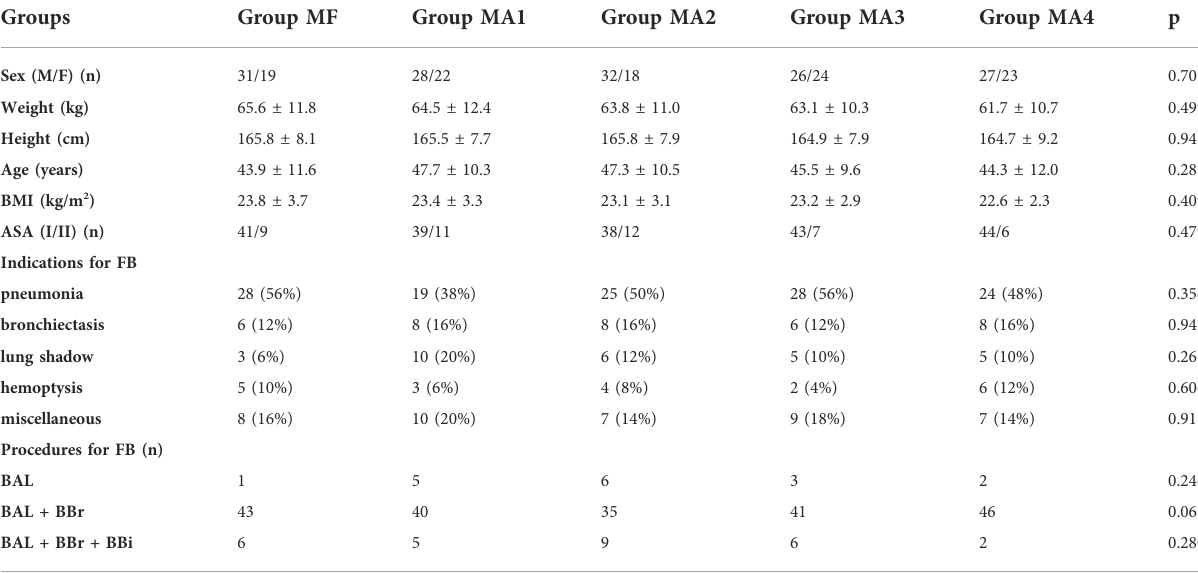
TABLE 1 Patient characteristics, Indications and Brochoscopic Procedures (n = 50).